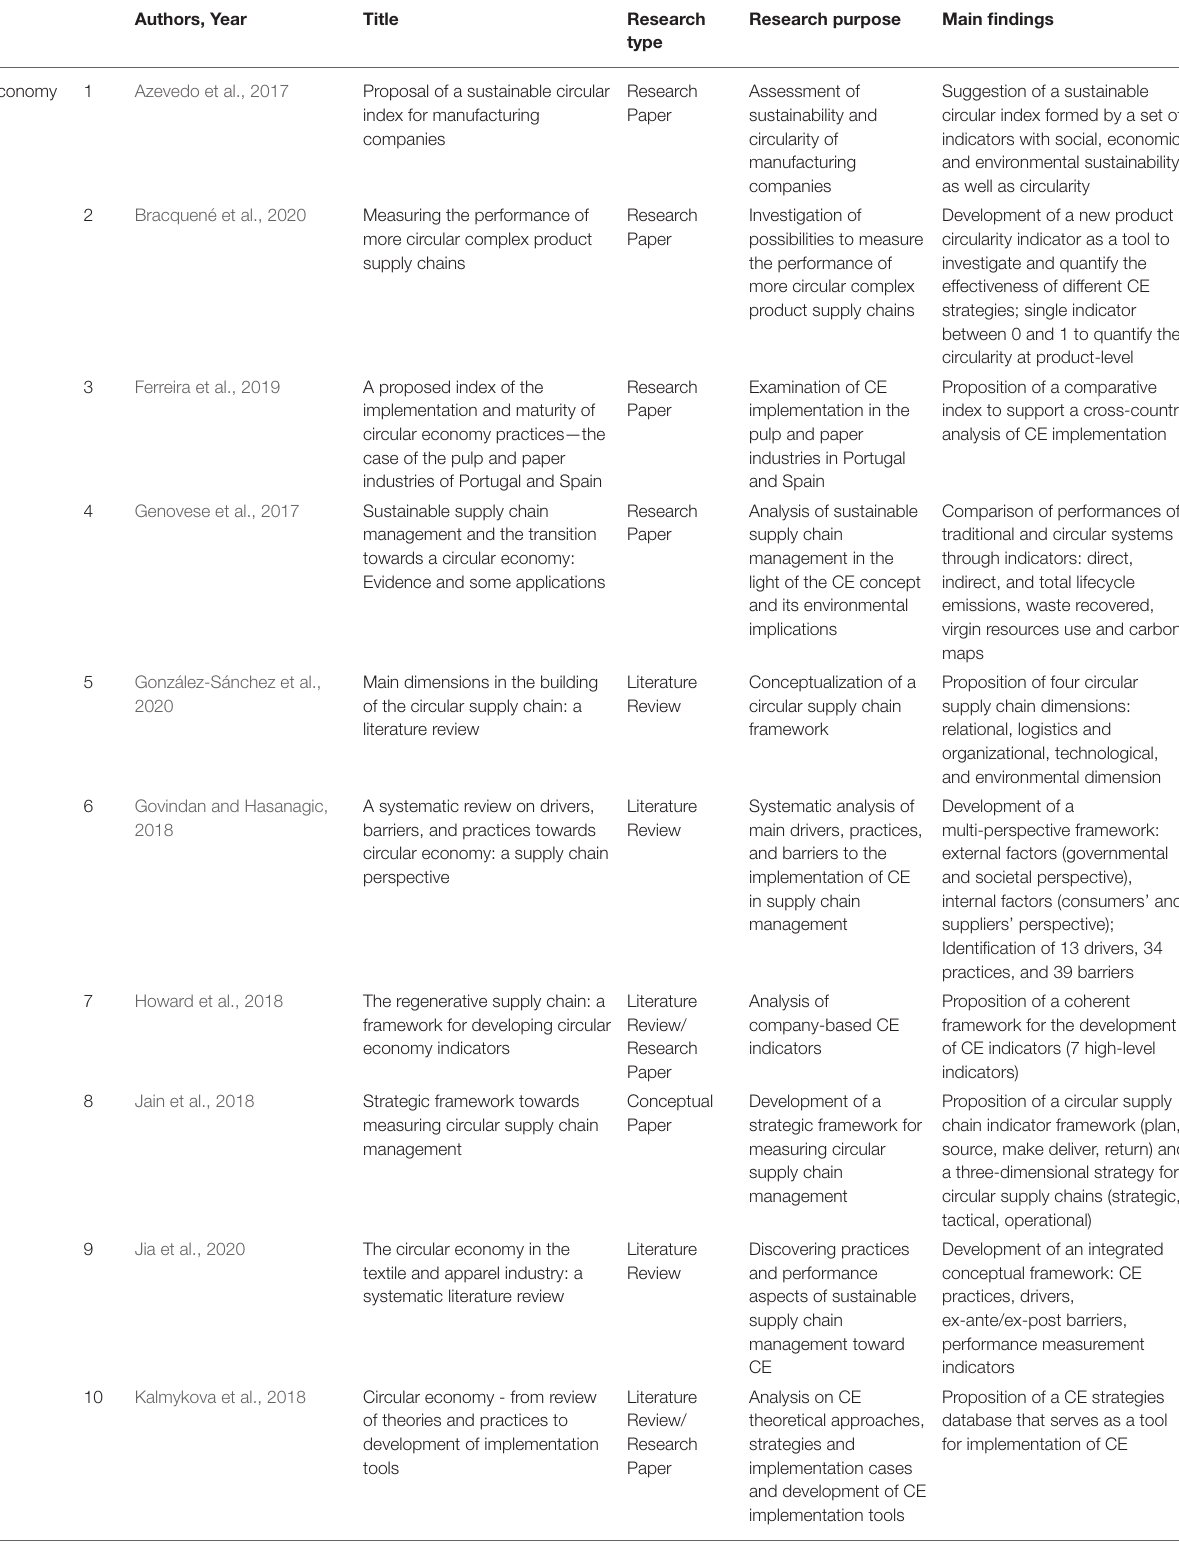
TABLE 1 | Final set of 35